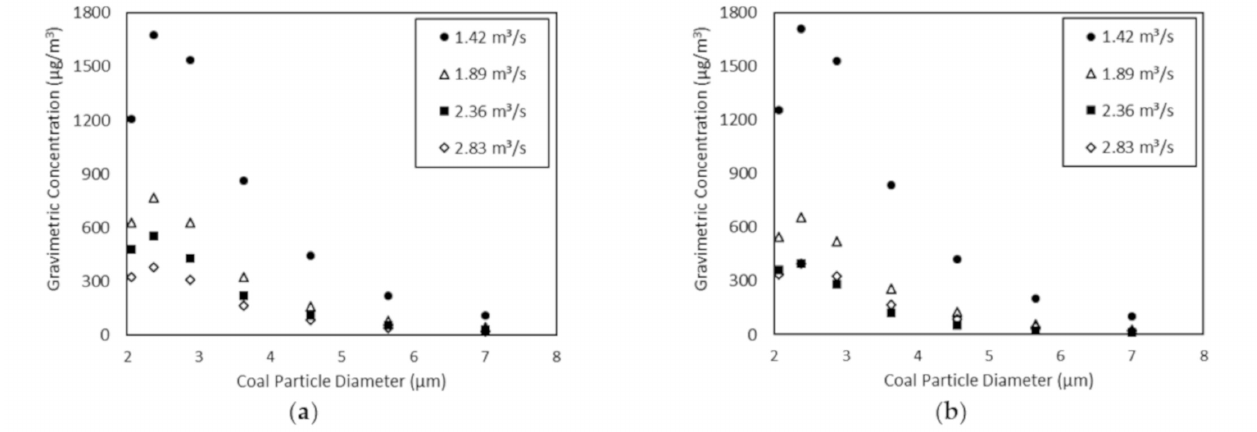
Figure 5. ( a ) Dust-concentration downstream with the water inflow of 18.9 l/min; ( b ) dust-concentration downstream with the water inflow of 22.7